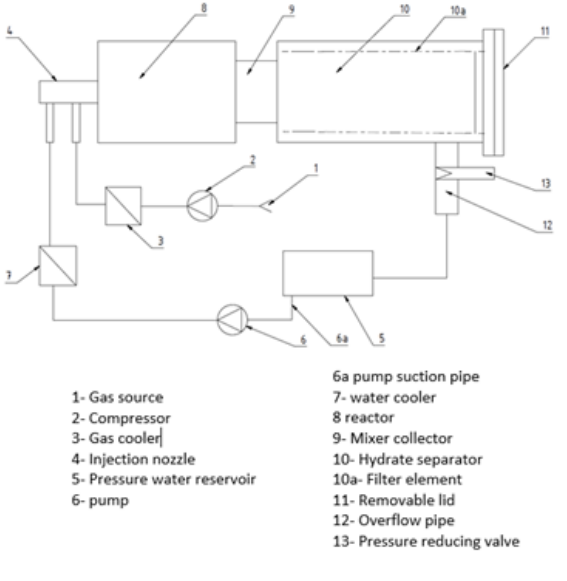
Figure 3. Proposed gas hydrate creation